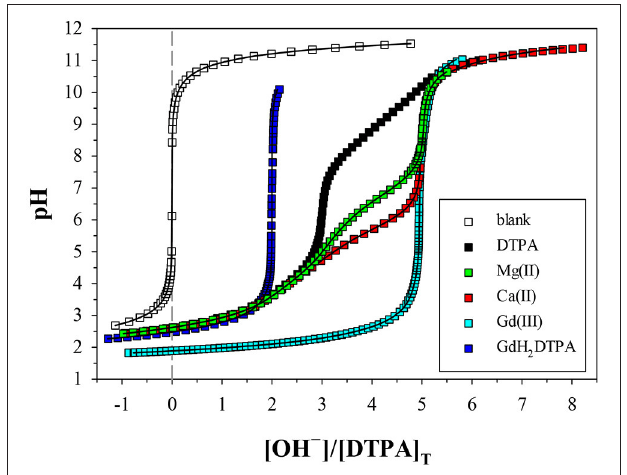
FIGURE 4 | Derivatives of the titration curves in Figure 3 , taken with respect to the x-coordinate. Peaks indicate low buffer intensity. The DTPA curve has a prominent peak at R = 3, corresponding to the release of three protons at low pH, and fainter peaks at R = 2, 4, and 5. The metal curves have a prominent peak at R = 5, indicating strong interaction with the fully deprotonated ligand. The fainter peak at R = 3 for Mg is from a higher fraction of free ligand, resulting from the lower stability of its DTPA complexes. The Gd curve (not scaled) has an M:L ratio of 0.85; 15% is present as free DTPA and 85% as virtually inert Gd–DTPA complexes, yielding a peak at 0.15 × 3 + 0.85 × 5 = 4.71. The GdH 2 DTPA compound has only two protons, producing a single peak at R =